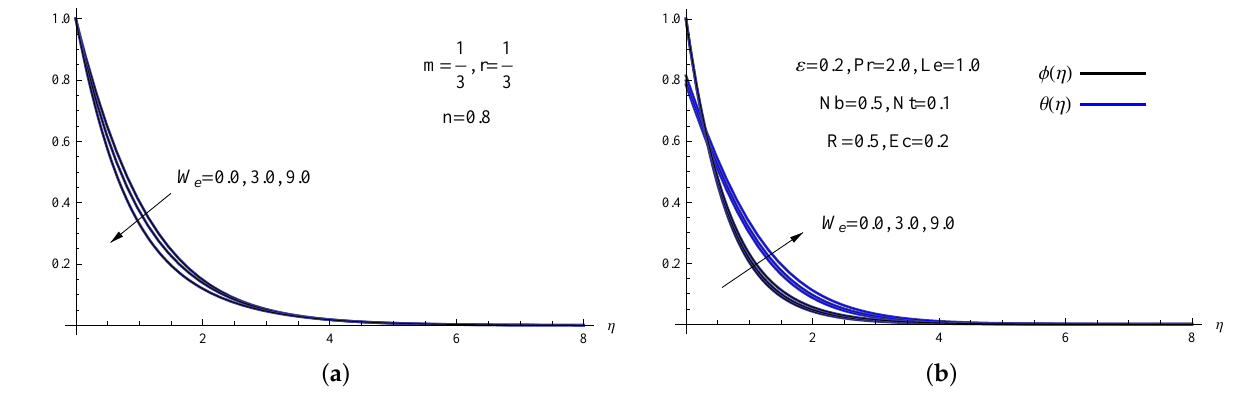
Figure 3. ( a ) f (cid:48) ( η ) via W e ; ( b ) θ ( η ) and φ ( η ) via W e . In Figure 4, for various values of the radiation parameter R , temperature θ ( η ) and concentration φ ( η ) profiles throughout the boundary layer with variable heat flux are shown. This figure shows, as anticipated, that both the temperature profiles θ ( η ) along the sheet and the sheet temperature θ ( 0 ) demonstrate a decreasing behavior as the radiation parameter R rises, whereas the inverse correlation is seen away from the sheet for the temperature profiles θ ( η ) . Since k ∗ reduces as the divergence of the radiative heat flux ∂ q r grows, the rate of radiative heat transfer to the fluid also increases, raising the fluid’s ∂ y temperature. So, the thickening of the thermal boundary layer is caused by the radiation parameter R . In terms of physics, this allows the fluid to escape the heat energy from the flow zone and cools the system. Further, we notice that the radiation parameter has a minimal impact on the concentration profiles across the whole boundary layer since it indirectly influences the concentration field. Moreover, the pioneering work of Megahed [27], which supports our present findings, shows that the radiation parameter has the same impact on the thermal field when heat flux is present.